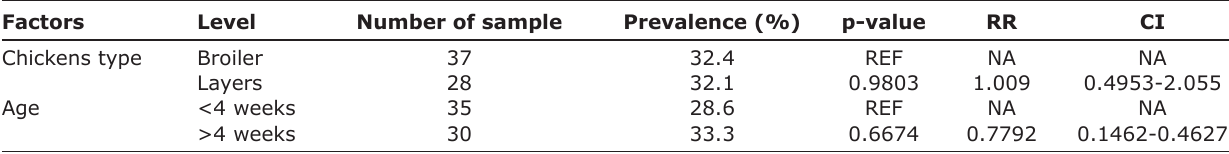
Table-3: Occurrence of ESBL-producing E. coli in chickens from small-scale poultry farms in Maiduguri based on chicken types and age. Factors